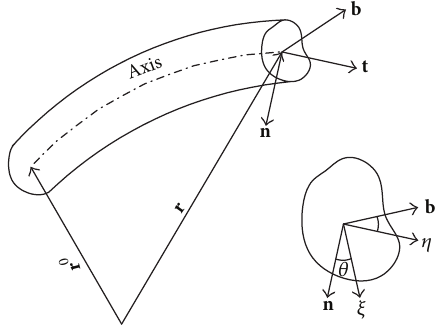
Figure 1: Geometry of a naturally curved and twisted